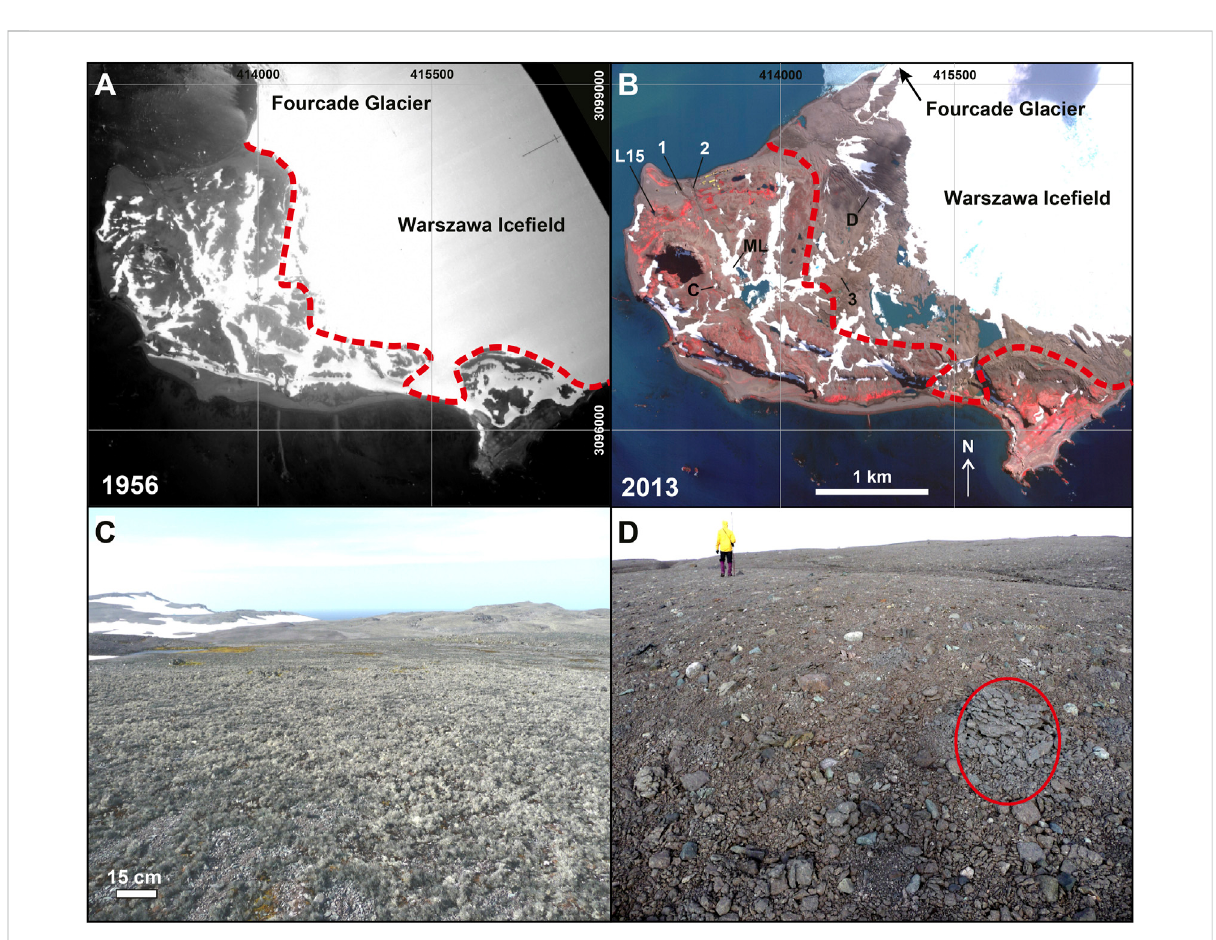
FIGURE 3 (A) Comparison between the positions of the tidewater Fourcade and inland Warszawa glaciers in 1956 CE (aerial photograph) and (B) 2013 CE (satellite image). Due to the extended snow cover season, locating the position of the terrestrial glacier margin is challenging, and retreat limits (red dotted lines) should be viewed as maxima. (B) Composite satellite image (NIR-G-B) of Potter Peninsula in 2013 with red areas re fl ecting the vegetation cover (mostly lichens). (C,D) Vegetated and recently deglaciated glacial deposits, respectively, of the glacial landform assemblages. Note the action of freeze-thaw processes causing laminated cracking in pyroclastic lithologies (red circle in D). (A,B) Stratigraphic sections and new lakerecordsarelabeledasfollows:1,newPingfoII;2,new “ PotterCove ” section;3,Inlandglacialdeposits;L15,LakeL15;ML,MatiasLake.SeeFigures 5 – 7 for stratigraphic pro fi les. The locations of photographs shown in Panels (C,D) are marked. To infer the area deglaciated in recent decades, we used an orthorecti fi ed panchromatic aerial image of 1956 CE in (A) (Falkland Island Dependency Aerial Survey Expedition, FIDASE; image